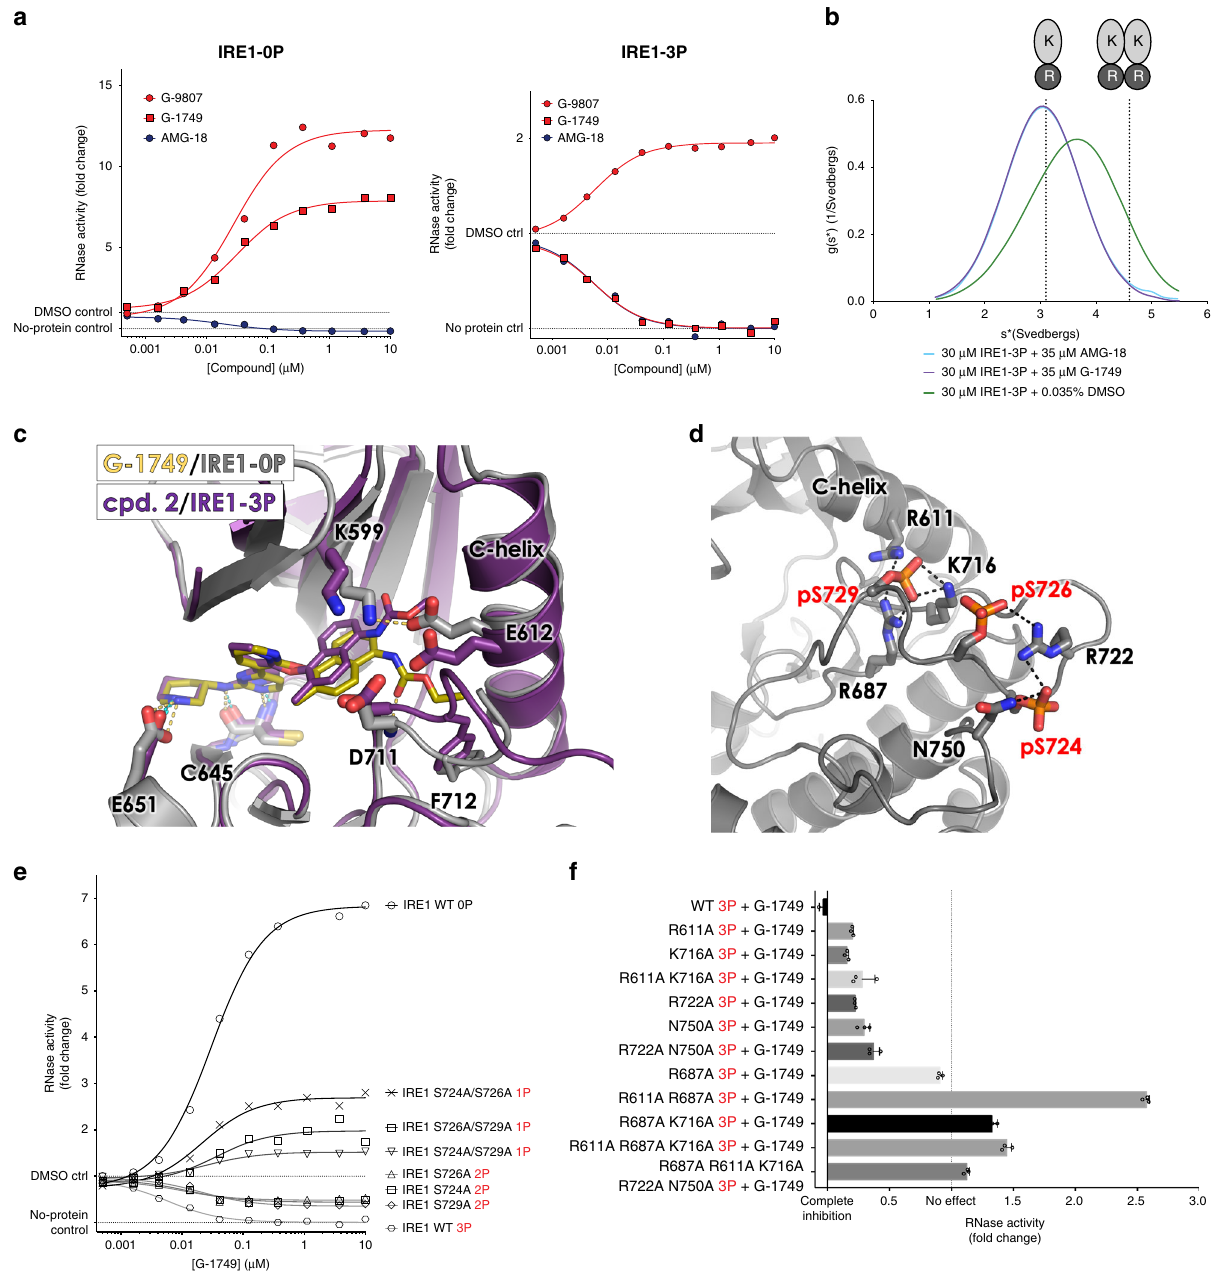
Fig. 5 G-1749 modulation of IRE1 RNase is dependent on the kinase phosphorylation state. a IRE1 RNase activity in the presence of AMG-18, G-9807, or G-1749. RNase activity was measured by the same assay as Fig. 1, but using an IRE1 KR construct (G547-L977) unphosphorylated (0P, left), or fully phosphorylated (3P, right) on S724, S726, S729. Source data are provided as a Source Data fi le. Data are presented as the mean for measurements from two independent experiments ( n = 2). b (SV-AUC) experiments for IRE1 LKR autophosphorylated alone or in the presence of slight excess G-1749 or AMG-18. Source data are provided as a Source Data fi le. c Co-crystal structure of 2 (purple sticks) in complex with IRE1-3P (purple cartoon) aligned with co-crystal structure of G-1749 (gold sticks) in complex with IRE1-0P (gray cartoon). d Details of the IRE1 kinase activation loop from the crystal structure of apo IRE1-3P (green cartoon). Phosphorylated serines and interacting residues are highlighted in sticks. e RNase activity for IRE1 KR phosphoserine S/A mutants in the presence of increasing concentration of G-1749. 1P or 2P refers to the phosphorylation state of each mutant, as veri fi ed by intact mass spectrometry and phosphorylation mapping after protein digestion (see “ Methods ” and SI). Background from the no-protein control was subtracted from signal before calculating fold change. Source data are provided as a Source Data fi le. Data are presented as the mean for measurements from two independent experiments ( n = 2). f RNase activity in the presence of 10 µ M G-1749 for fully phosphorylated IRE1 KR mutants of residues that would interact with phosphoserines, as in ( d ). Background from the no-protein control was subtracted from signal before calculating fold change. Source data are provided as a Source Data fi le. Data are presented as the mean and S.D. for measurements from three independent experiments ( n =